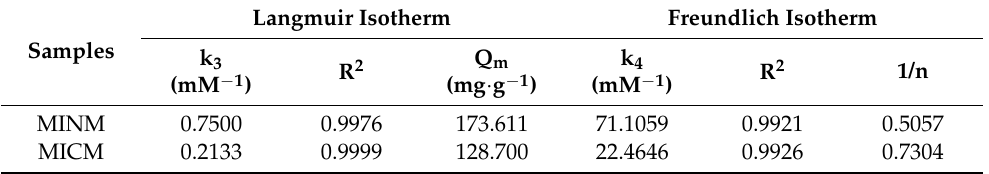
Table 2. Parameters of Langmuir adsorption model and Freundlich adsorption